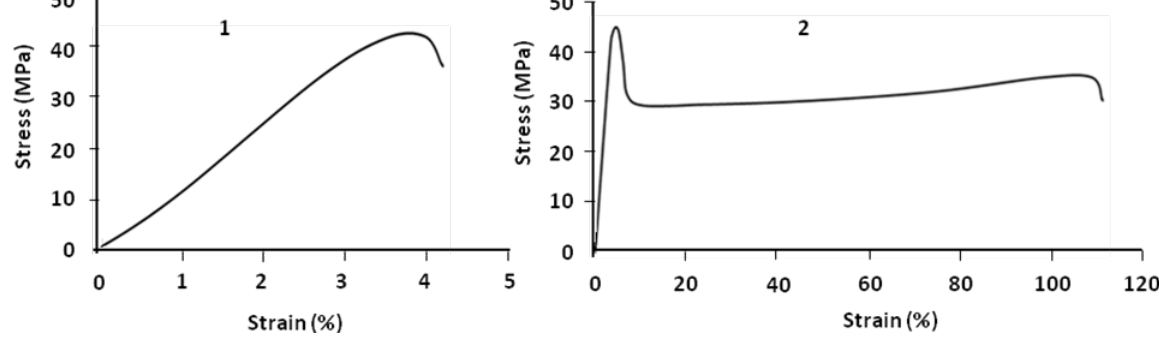
Figure 3. Stress–strain curves of PLA (80%)/PBS (20%) at 24 °C: perpendicular ( 1 ) and parallel ( 2 ) samples.